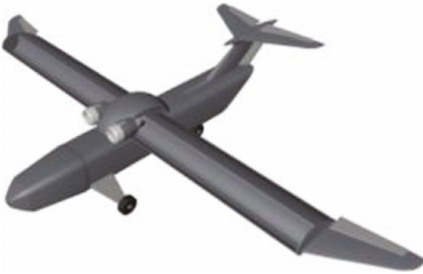
Figure 3: A new concept aircraft with a DJBW.